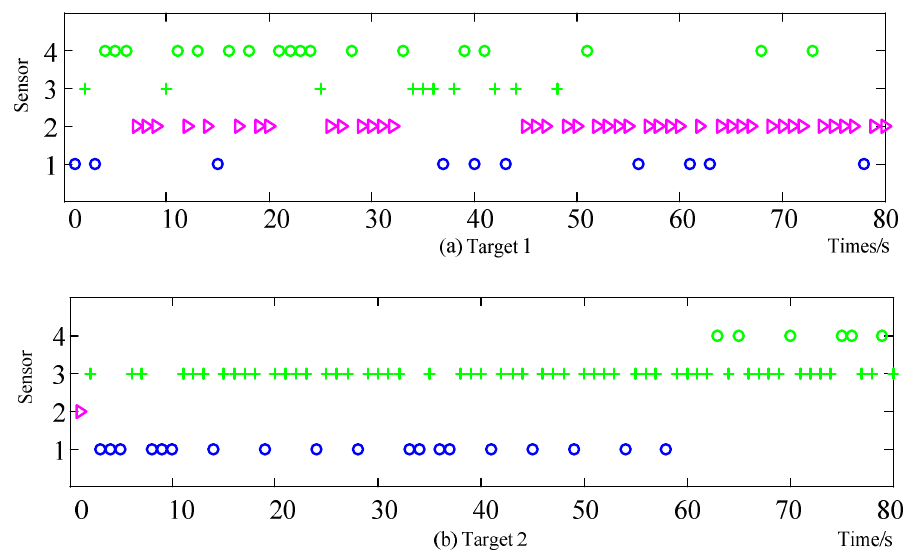
Figure 20. Sensor selected sequences obtained by IPFSP. ( a ) Target 1; ( b ) Target 2.